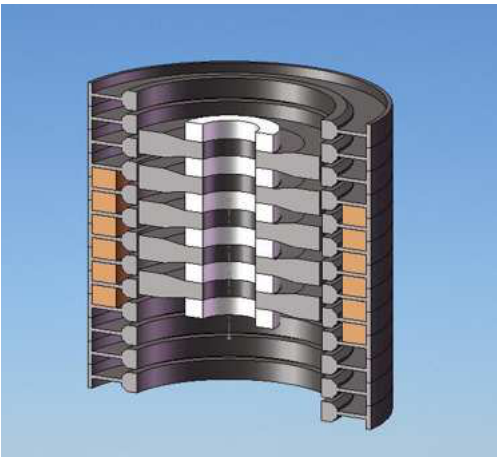
Figure 8. Section of the optimized